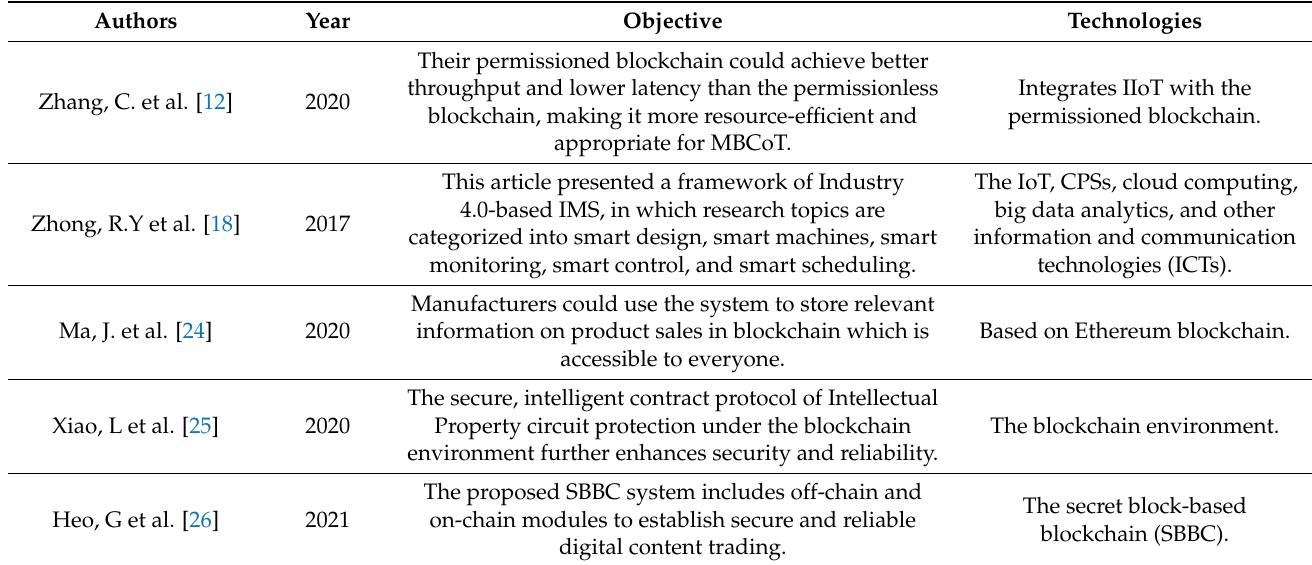
Table 1. Comparison with various manufacturing